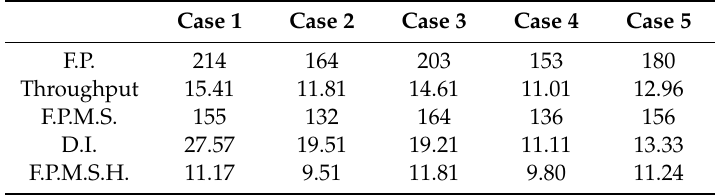
Table 1. Results table. Six results are summarized: finished products (F.P); finished products that meet specifications (FPMS); finished products per hour (throughput); defect index (D.I.); finished products that meet specifications per hour (FPMSH).